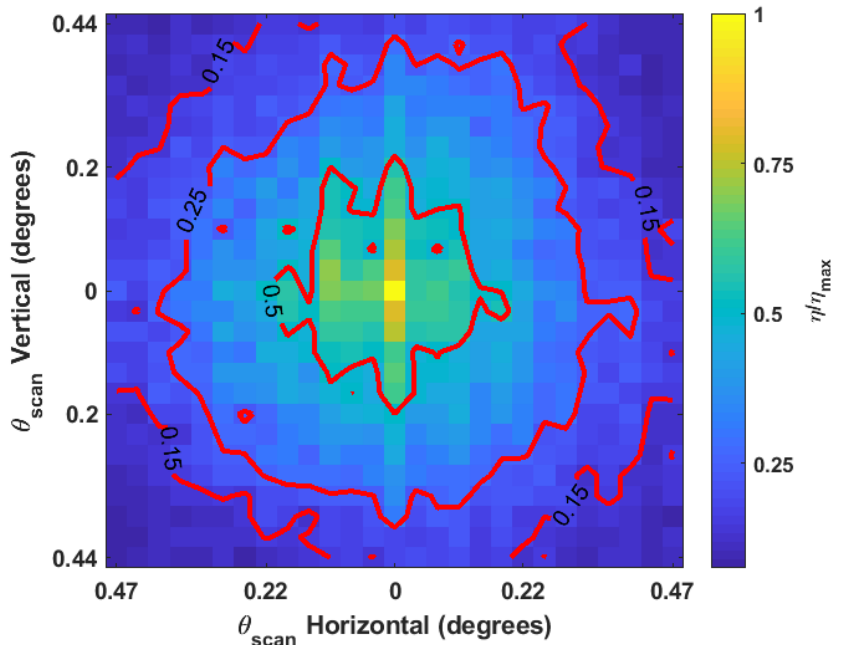
Figure 4. Experimental enhancement of displaced spot as a two-dimensional function of displacement size after a circular shift of the SLM phase map of a focal plane system shown in Figure 1 for 600- grit polished nickel. Results were averaged over five trials. The maximum value of η prior to normalization was 89.9 ± 1.5.